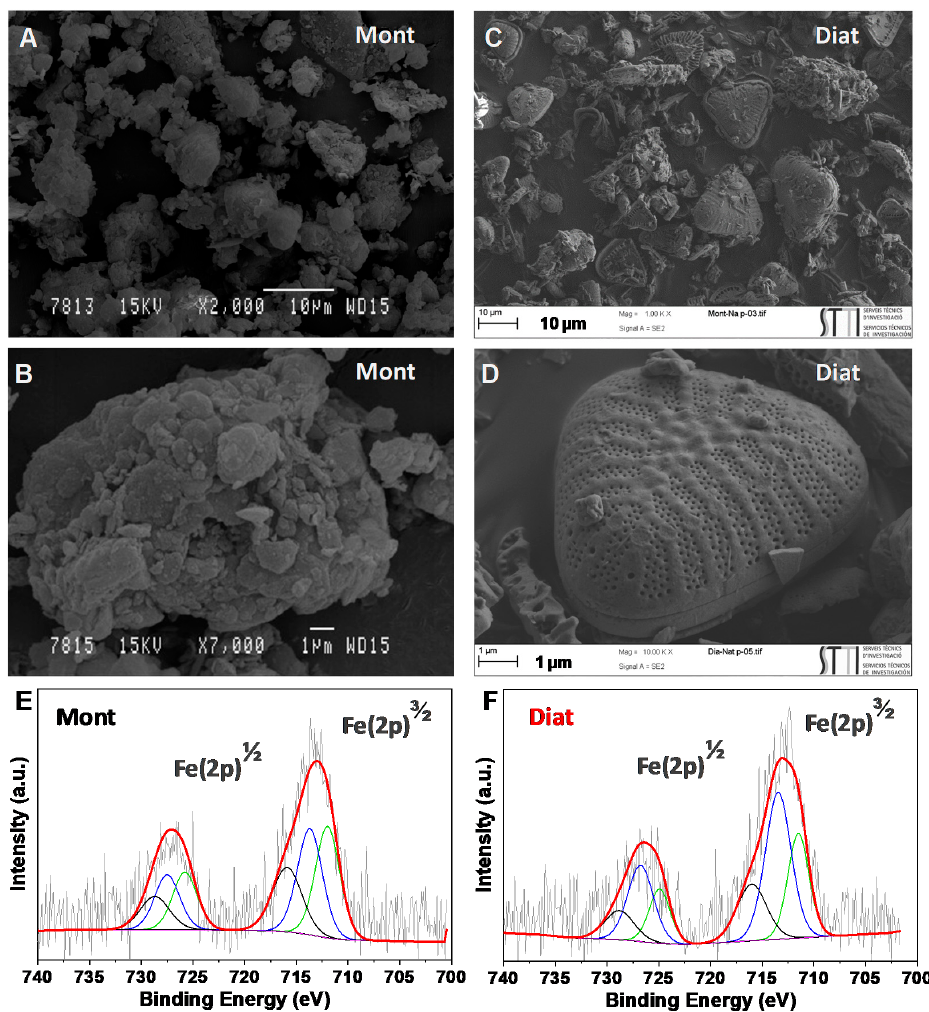
Figure 1. FE-SEM images at different magnifications of Mont ( A,B ) and Diat ( C,D ) clays (with sputter-coated C powder); and their corresponding Fe(2p) core-level XPS spectra ( E and F , respectively).